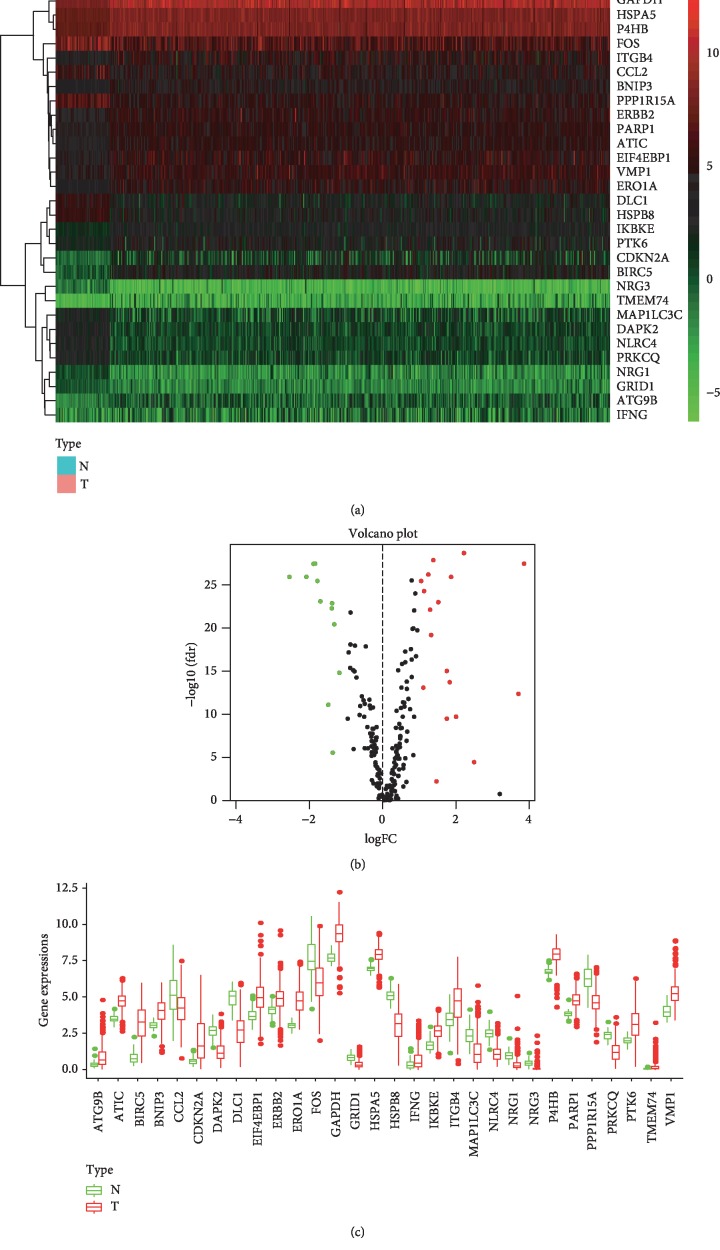
The differentially expressed autophagy genes between lung adenocarcinoma and normal tissues. (a) Heatmap of DEAGs, with red indicating high expression and green indicating low expression. (b) Volcano plot of DEAGs, with red dots indicating high expression and green dots indicating low expression. (c) Box plot of DEAGs, with the red boxes representing the tumor group and green boxes representing the normal group.